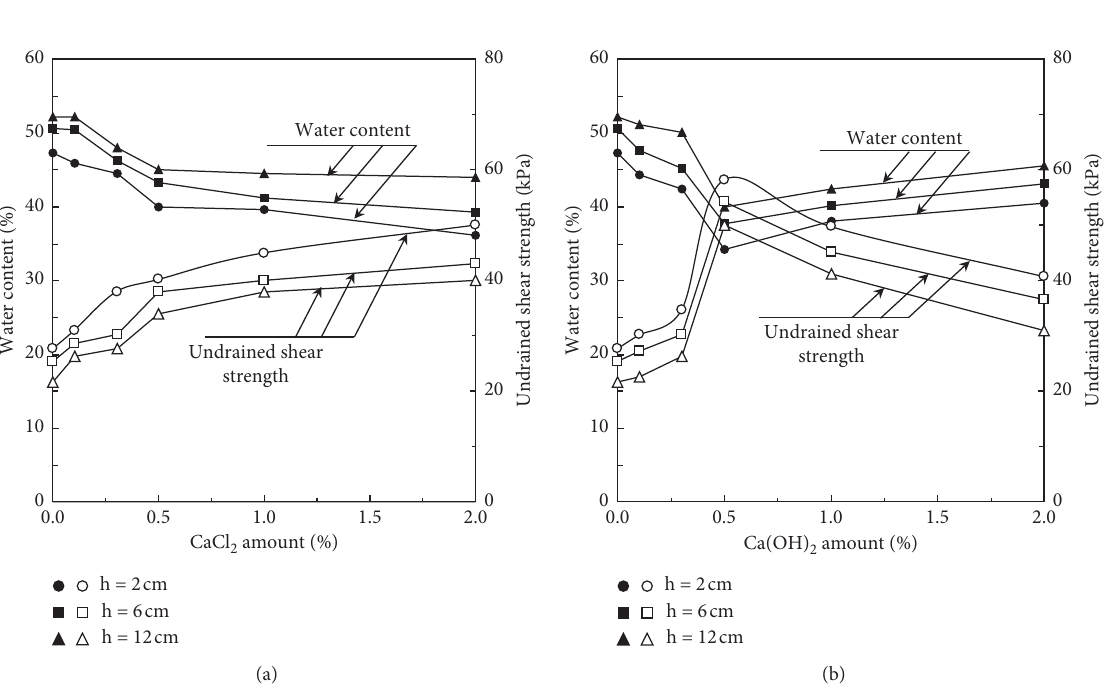
Figure 11: Variation of water content and undrained shear strength after vacuum preloading